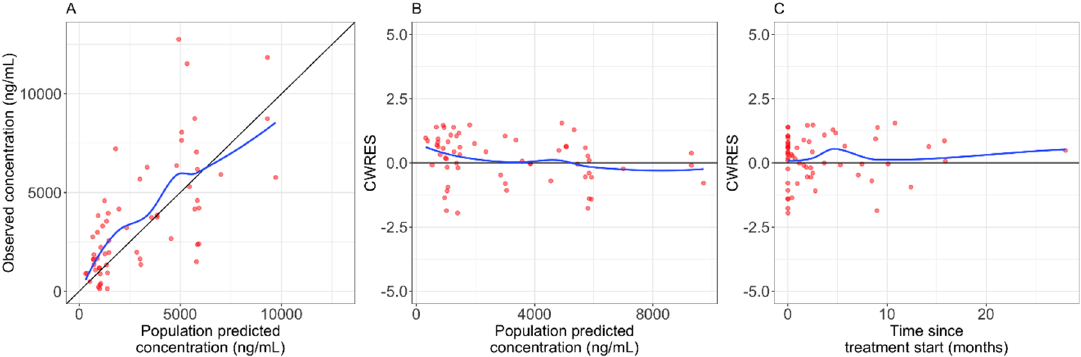
Figure A2. Goodness-of-fit plots. ( A ) Observed vs. population predicted concentrations; ( B ) Conditional weighted residuals vs. population predicted concentrations; ( C ) Conditional weighted residuals vs. time since treatment start. The blue line is the local regression.